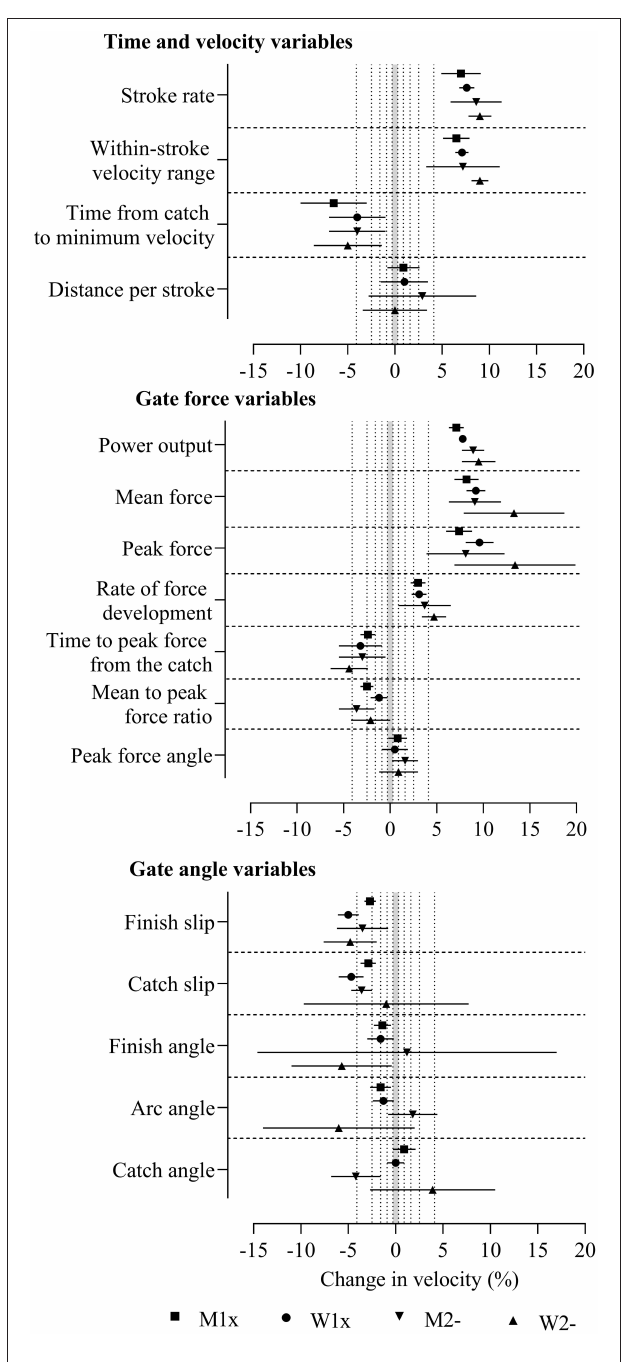
FIGURE 1 | Change in boat velocity for a change in each predictor variable of two within-crew standard deviations in the four boat classes without adjustment. Data are mean (%) and 90% compatibility limits. The shaded grey area covers values within the smallest important change thresholds (-0.3% to 0.3%). Vertical dotted lines delineate threshold magnitudes of small ( ± 0.3), moderate ( ± 0.9), large ( ± 1.6), very large ( ± 2.5), and extremely large ( ± 4.1). Rejection of the non-inferiority or non-superiority hypothesis occurs when compatibility limits do not enter the grey area. Effects with compatibility limits that end within the grey area have adequate precision but are only possibly or likely substantial. M1x, men’s single sculls; W1x, women’s singles sculls; M2-, men’s coxless pairs; W2-, women’s coxless